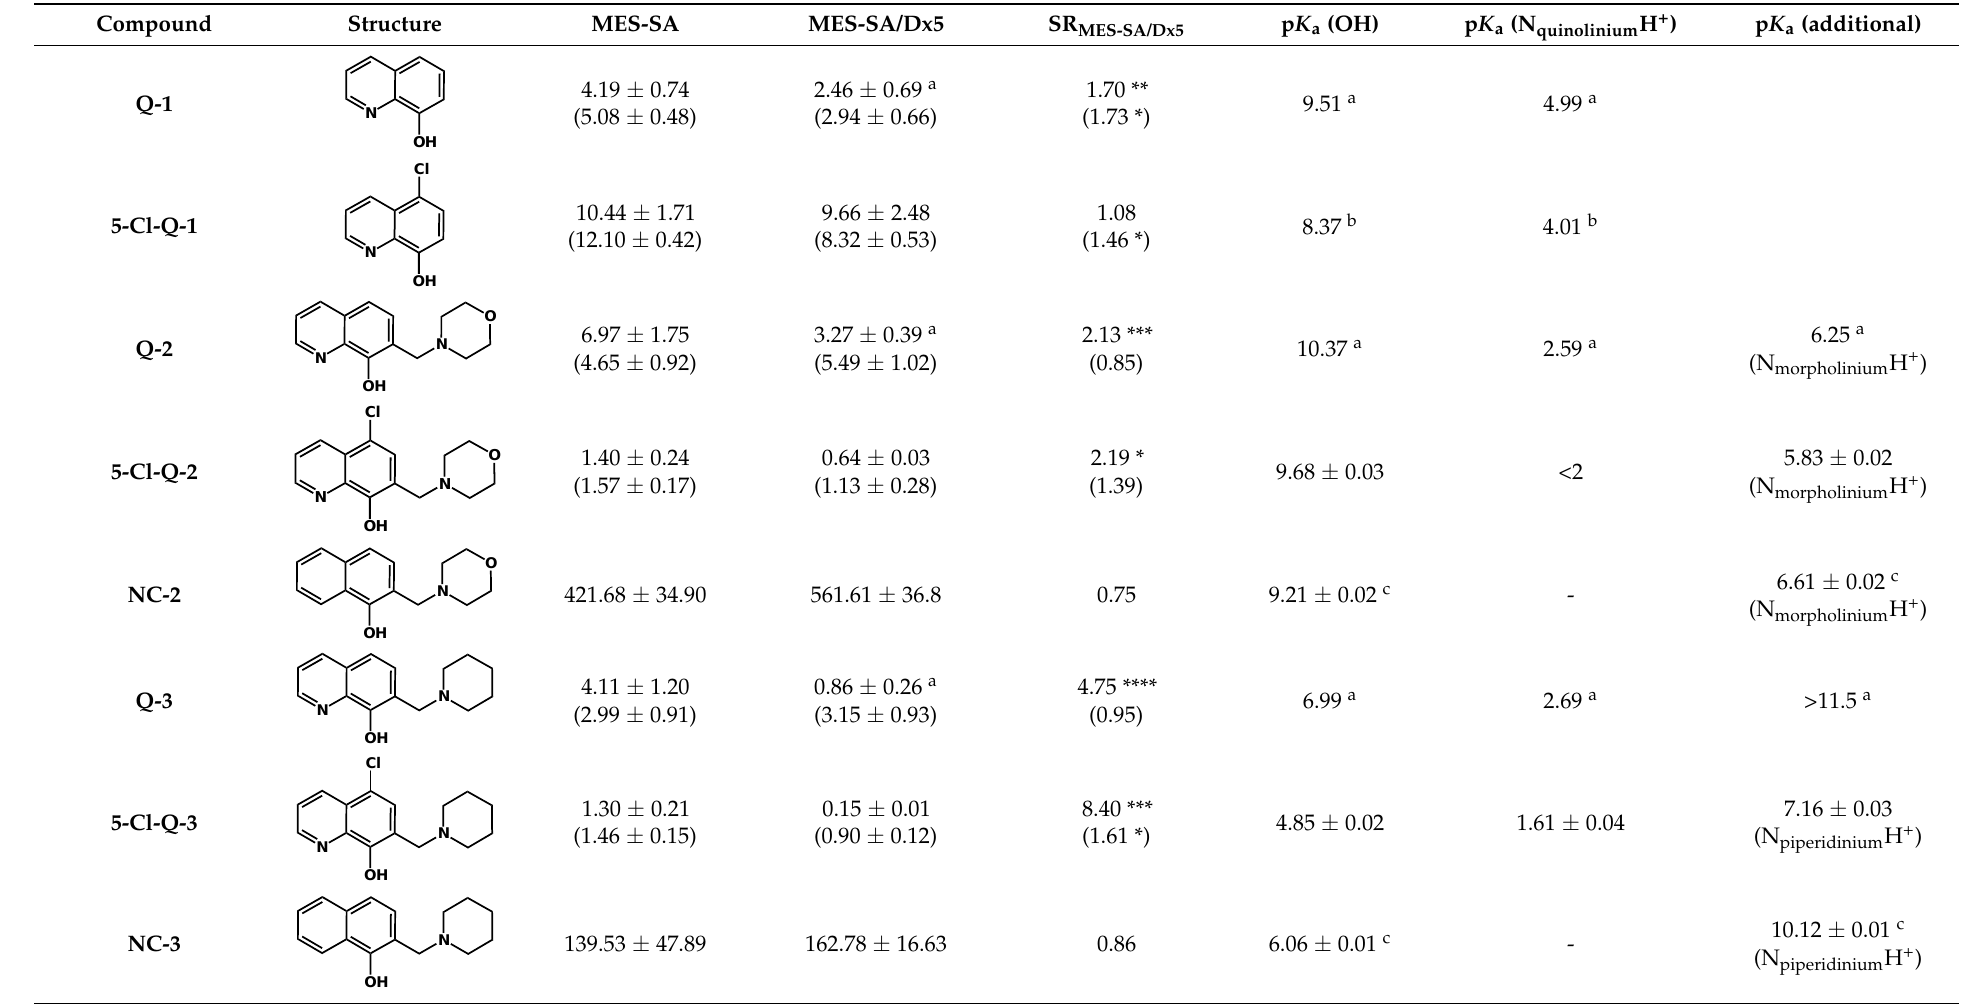
Table 2. pK a values and chemical structures of Q-1 to Q-4 and related compounds determined by UV-visible spectrophotometric titrations (T = 25 ◦ C, I = 0.2 M (KCl)). The non-chelating derivatives 2-(morpholino-methyl)naphthalen-1-ol NC-2 , 2-(piperidin-1-ylmethyl)naphthalen-1-ol NC-3 and 2-((2-fluorobenzylamino)methyl)naphthalen-1-ol NC-4 were used to monitor the lack of the quinoline nitrogen. Significance was calculated using unpaired t -tests; results are given as *: p ≤ 0.05, **: p ≤ 0.01, ***: p ≤ 0.001, ****: p ≤ 0.0001. Compound